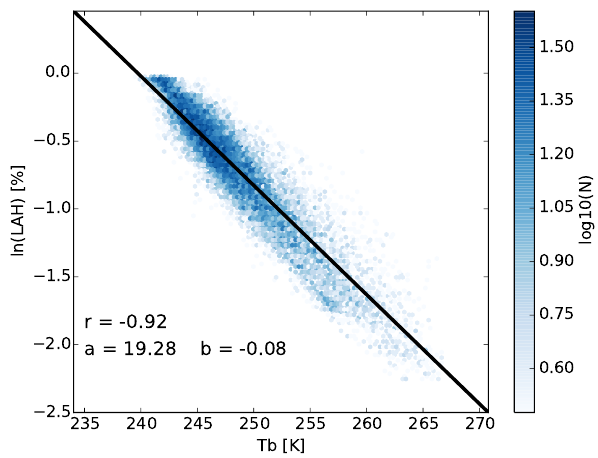
Figure 4. Relation between satellite Tb and natural logarithm of layer-averaged RH I . The color bar shows the logarithm of the num- ber of observations.